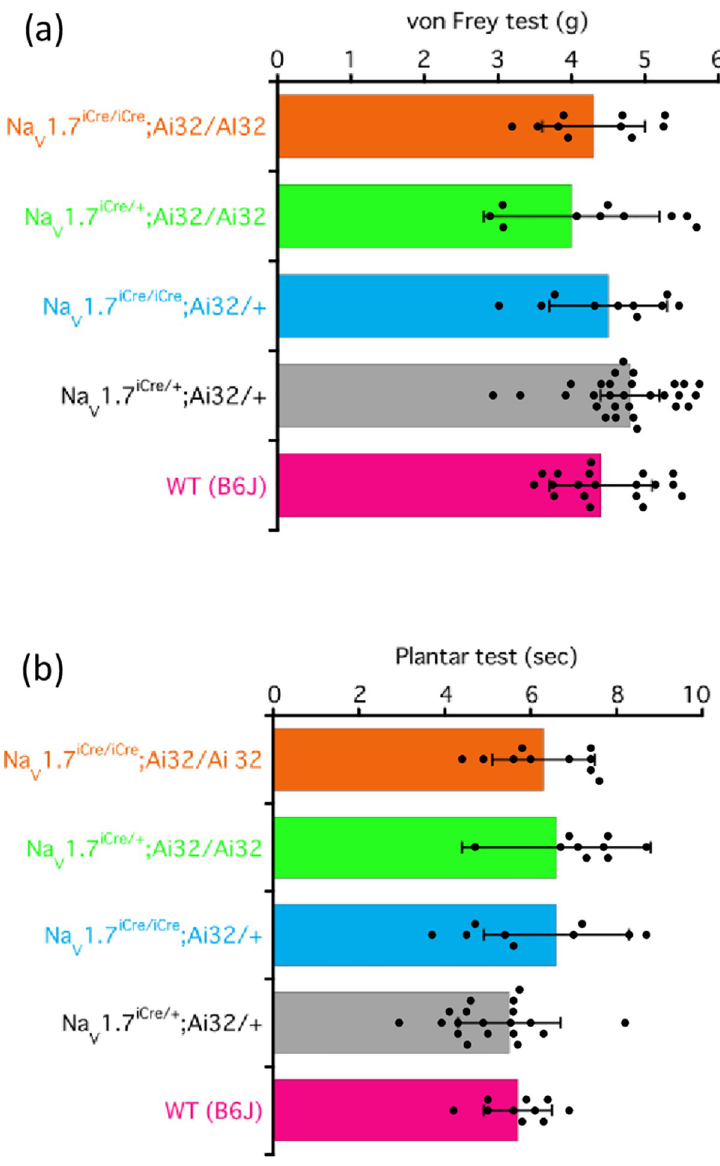
Fig 3. Paw withdrawal test (von Frey test) (a) and plantar test (b). (a) The von Frey test was performed with the wild type (WT) and mice of the four genotypes. The hind paw withdrawal data were analyzed using one-way ANOVA. All results are calculated as mean ± SD of 10 or more animals. Individual results for each strain are as follows: WT (B6J), 4.4 ± 0.7 g; Na V 1.7 iCre/+ ;Ai32/+, 4.8 ± 0.4 g; Na V 1.7 iCre/iCre ;Ai32/+, 4.5 ± 0.8 g; Na V 1.7 iCre/+ ;Ai32/Ai32, 4.0 ± 1.2 g; and Na V 1.7 iCre/iCre ;Ai32/Ai32, 4.3 ± 0.7 g. (b) The plantar test was performed with the WT and mice of the four genotypes. The data were analyzed using one-way ANOVA. All results are calculated as mean ± SD of 10 or more animals. Individual results for each strain were as follows: WT (B6J), 5.7 ± 0.8 s; Na V 1.7 iCre/+ ;Ai32/+, 5.5 ± 1.2 s; Na V 1.7 iCre/iCre ; Ai32/+, 6.6 ± 1.7 s; Na V 1.7 iCre/+ ;Ai32/Ai32, 6.6 ± 2.2 s; and Na V 1.7 iCre/iCre ;Ai32/Ai32, 6.3 ± 1.2 s. gene promoter without disrupting endogenous Na 1.7. Furthermore, using the Cre-loxP sys- V tem, we crossed homozygous Na 1.7–iCre (Na 1.7 iCre / iCre ) mice with homozygous Ai32 mice V V and generated a transgenic Na 1.7–ChR2 mouse line (Na 1.7 iCre / + ;Ai32/+) in which ChR2 V V was selectively targeted in Na 1.7-expressing sensory neurons. Thus, the Na 1.7–iCre trans- V V genic mouse line used in our study could have ChR2 channels delivered to peripheral